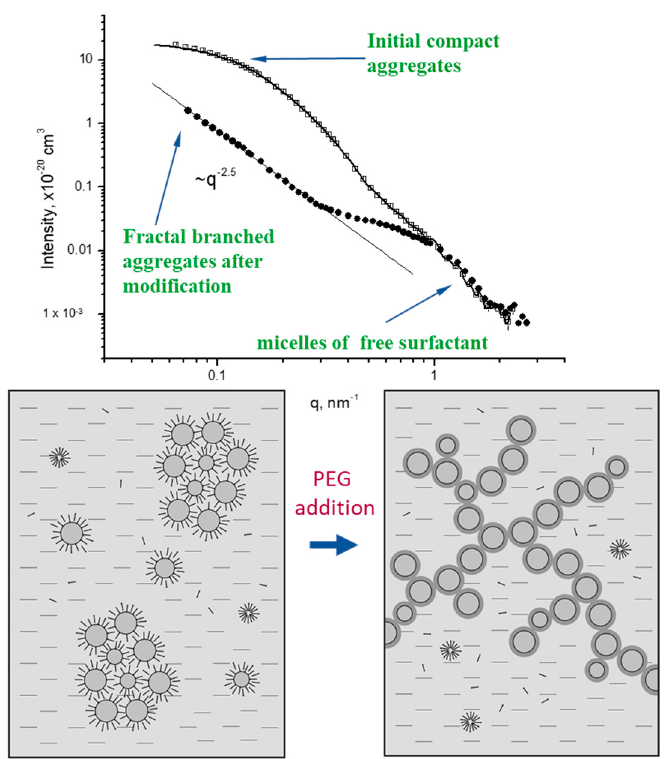
Figure 13. Ferrofluids with surfactant-polymer substitution: Change in aggregate structure according to small-angle neutron ( SANS) analysis. SANS signals from different components in the solution were marked by arrows. Reprinted with permission from Reference [145] (https://journals.iucr.org/).